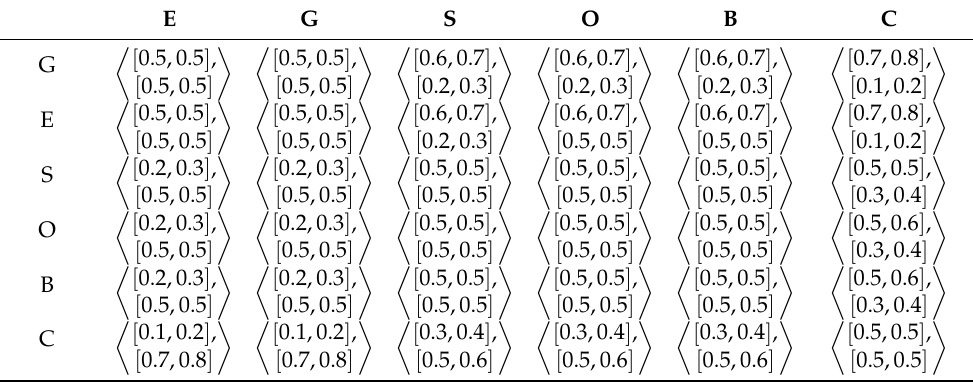
Figure 6. Graphic representation of ( a ) criteria weights and ( b ) sub-criteria weights. Table 10. Aggregated decision interval matrix in IVPF–AHP for the main criteria (CI = 0.0317228, CR = 0.0283239).